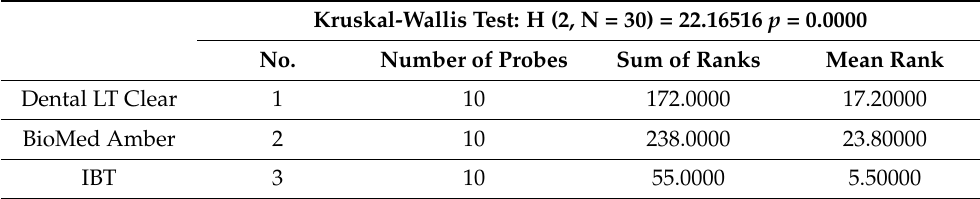
Table 3. Analysis of variance according to Kruskal–Wallis test on compression modulus